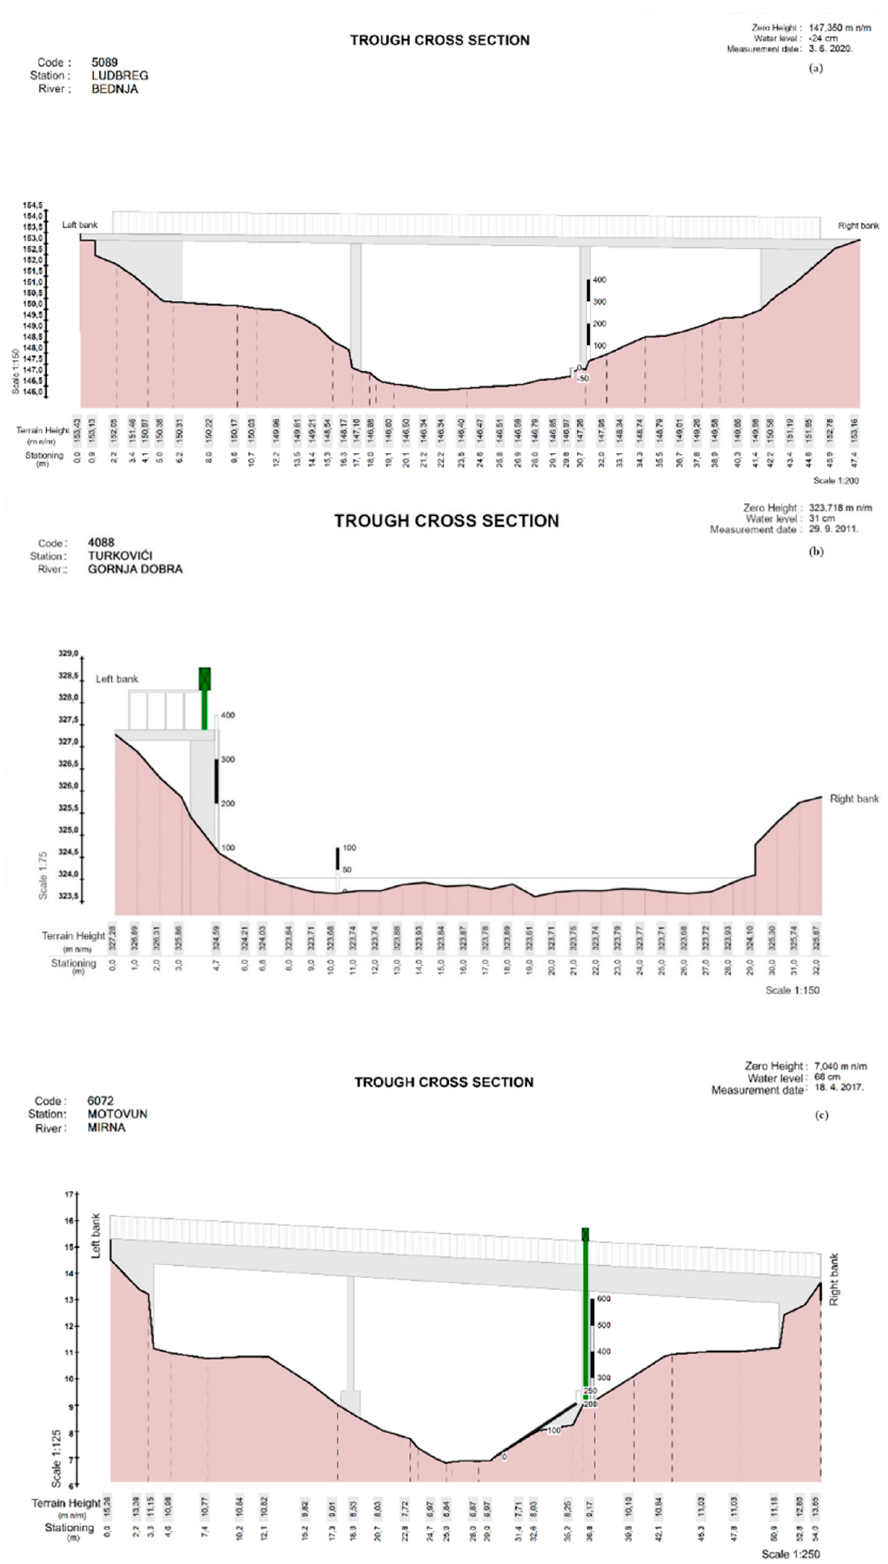
Figure 2. Riverbed cross section at the measuring station Ludbreg, Bednja River ( a ), measuring station Turkovi´ci, Gornja Dobra River ( b ), and measuring station Motovun, Mirna River ( c ).